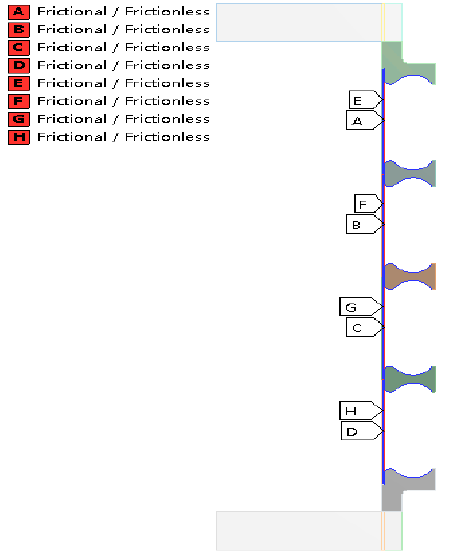
8 of 16 Figure 11. Von Mises strain at the wave after unloading. •